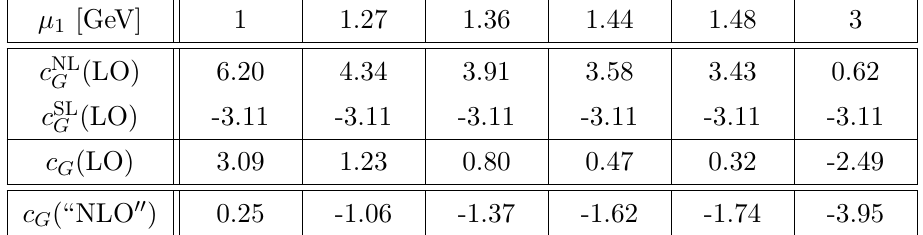
Table 6 . Comparison of the coefficients c SL renormalisation scale µ